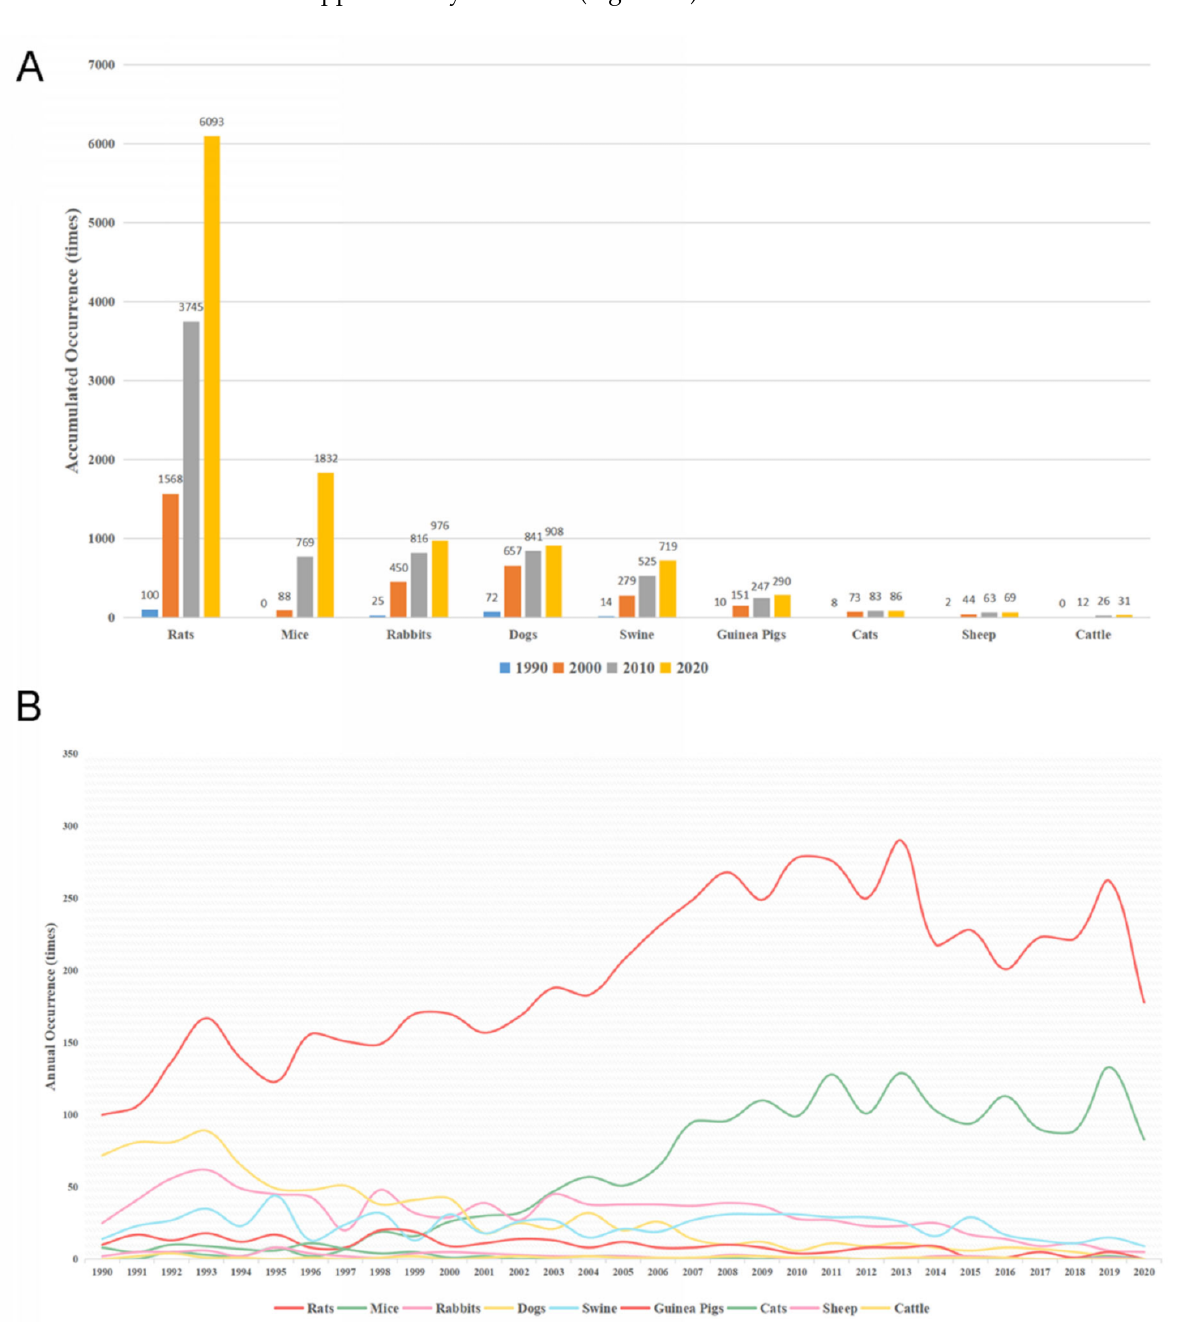
Figure 4. MeSH terms of animal types. ( A ) accumulated occurrence of MeSH terms every ten years; ( B ) annual occurrence of MeSH